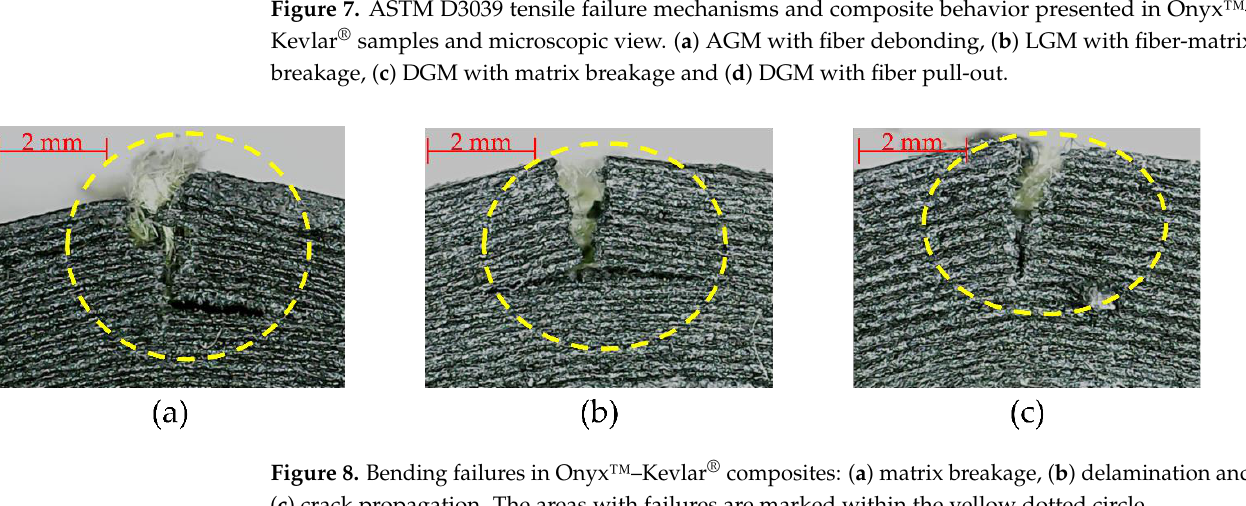
Figure 7. ASTM D3039 tensile failure mechanisms and composite behavior presented in Onyx™– Kevlar ® samples and microscopic view. ( a ) AGM with fiber debonding, ( b ) LGM with fiber-matrix breakage, ( c ) DGM with matrix breakage and ( d ) DGM with fiber pull-out.